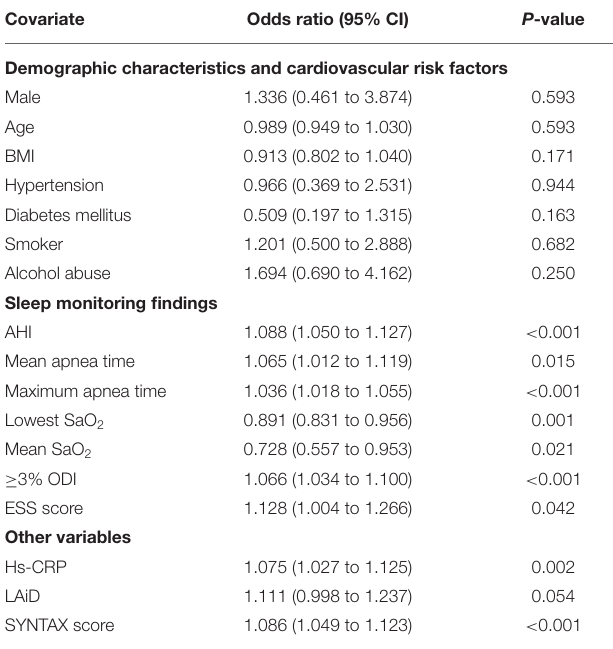
( Table 5 ). As the ROC analysis revealed, the AHI (AUC = 0.766, 95% CI 0.689 to 0.832, P < 0.001) and SYNTAX score (AUC =